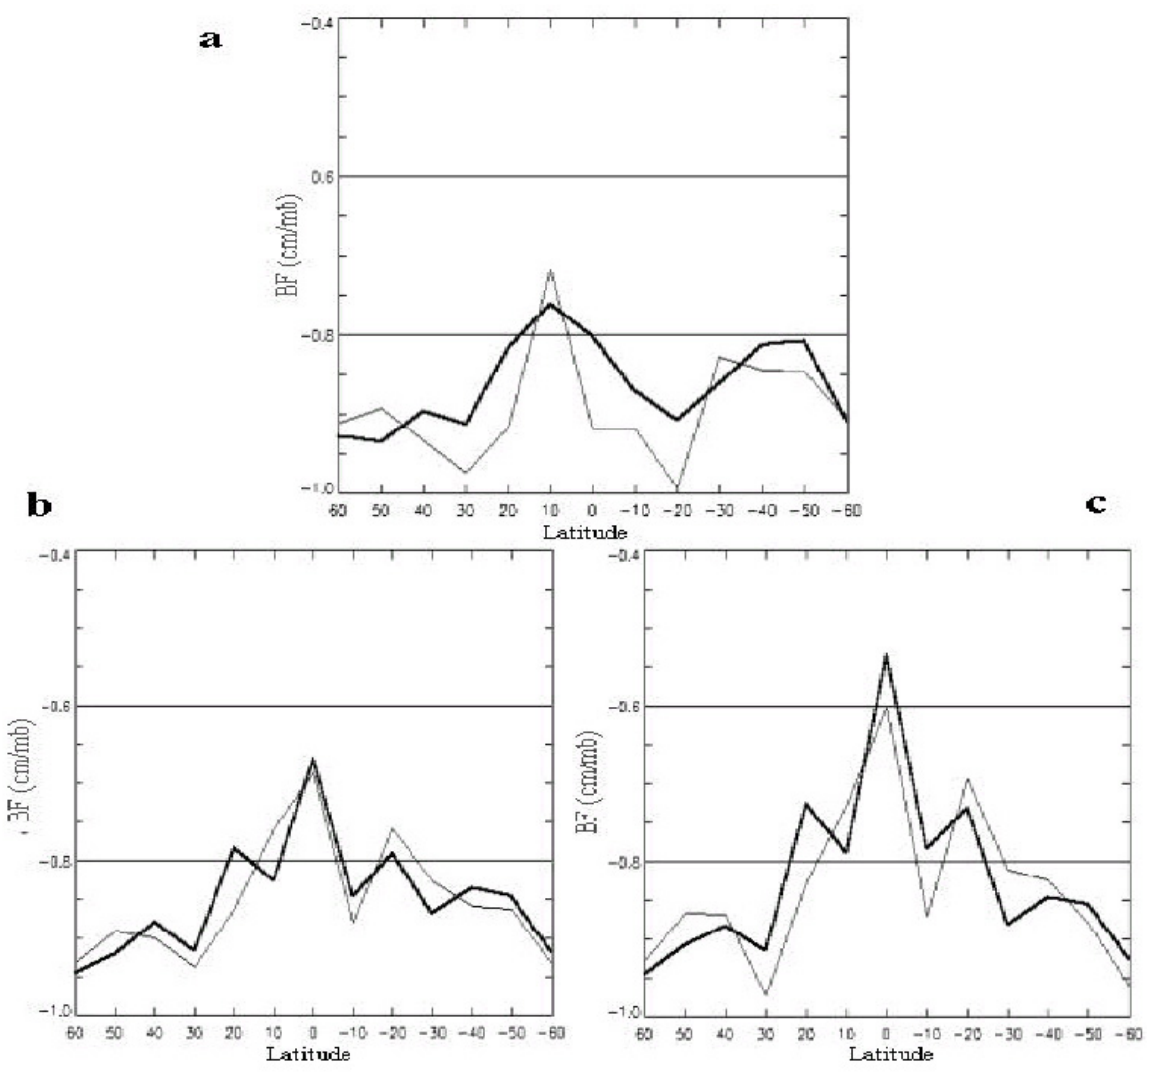
Fig. 10. Comparative between the meridional distribution of BF estimated using ERS-2 records (thin solid line) and the outputs of the Barotropic Ocean Model (gross solid line), considering the three time sampling used. (a) 1t = 35days, (b) 1t = 11days and (c) 1t =